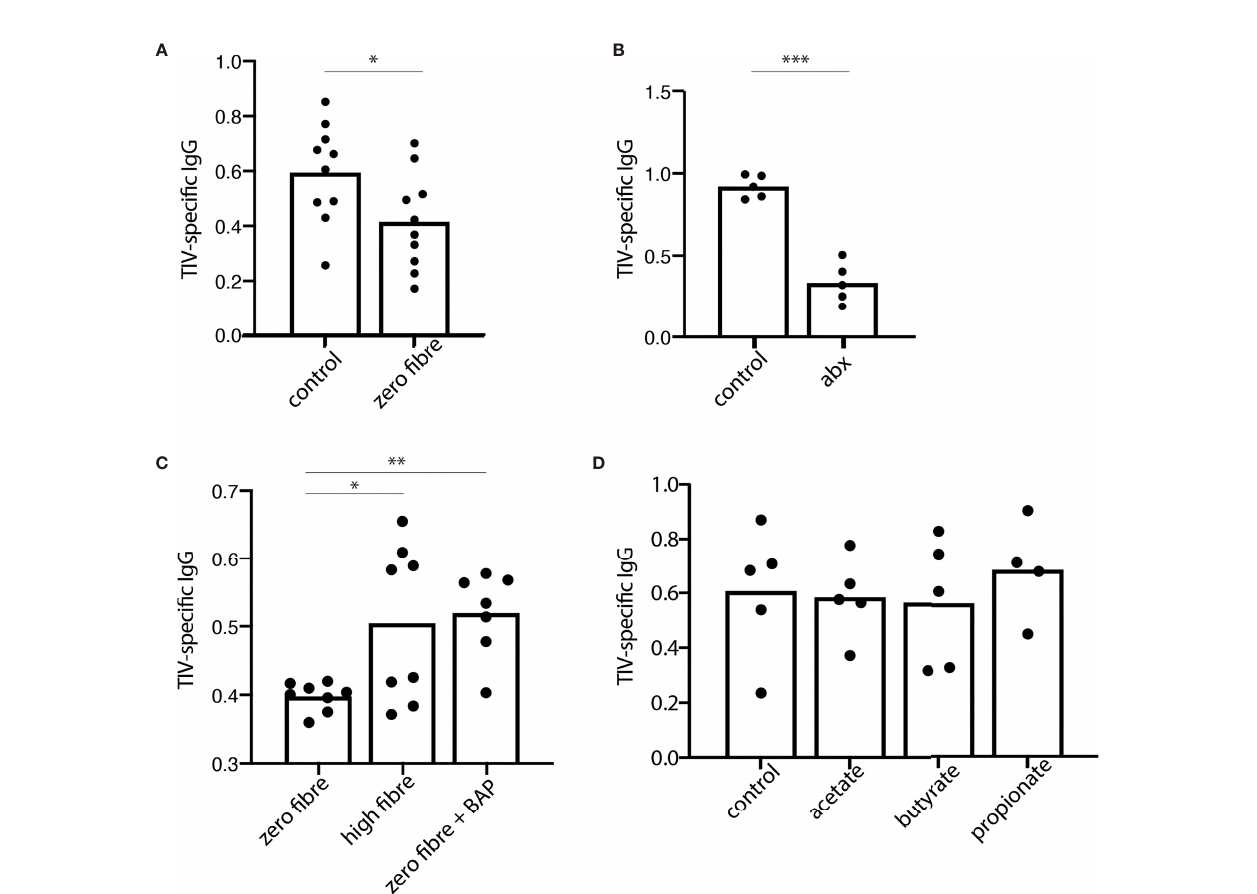
FIGURE 4 | Dietary fi bre and fi bre fermentation are required for optimal antibody response in a mouse model of in fl uenza vaccination. 28 days after receiving the trivalent in fl uenza vaccine (TIV), serum levels of TIV-speci fi c IgG were assessed from mice allocated to various fi bre interventions. (A) TIV-speci fi c IgG in the serum from mice fed a control or zero fi bre diet. (B) TIV-speci fi c IgG from mice on a control diet, with (abx) or without (control) the addition of an antibiotic cocktail to the drinking water. (C) TIV-speci fi c IgG from mice on a zero- fi bre diet, a high fi bre diet, or a zero fi bre diet supplemented with a cocktail of short chain fatty acids containing butyrate, acetate, and propionate (D) TIV-speci fi c IgG from mice on a control diet supplemented with acetate, butyrate, or propionate. Data from (A, C) are from two independent experiments; samples from replicate groups are combined for analysis [ (A) n=5/treatment/experiment (B) n=3-4/treatment/experiment]. Data from (B, D) are representative from 2 independent experiments (n = 5/treatment/experiment). Error bars in all panels show standard error of the mean. *P < 0.05. **P < 0.01. ***P < 0.001. BAP, butyrate, acetate, and